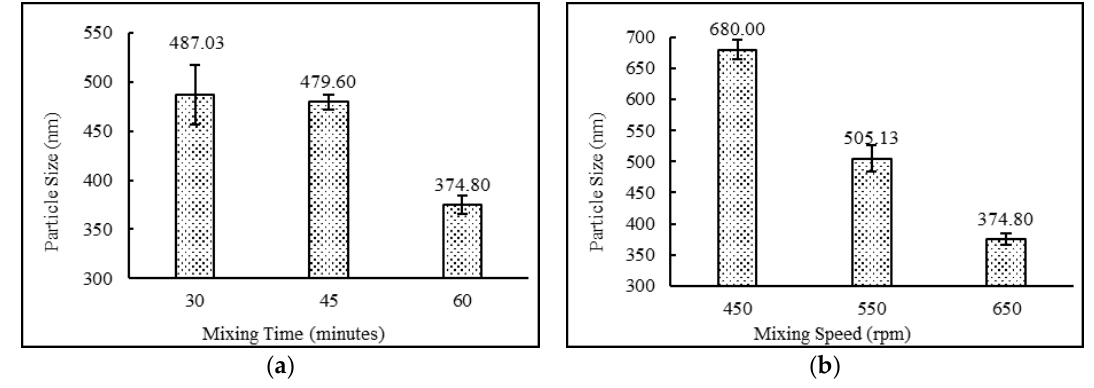
Figure 5. Effect of ( a ) mixing time (minutes) and ( b ) mixing speed (rpm) on particle size (nm) of niosomes. ( N = 3, mean ± SD).